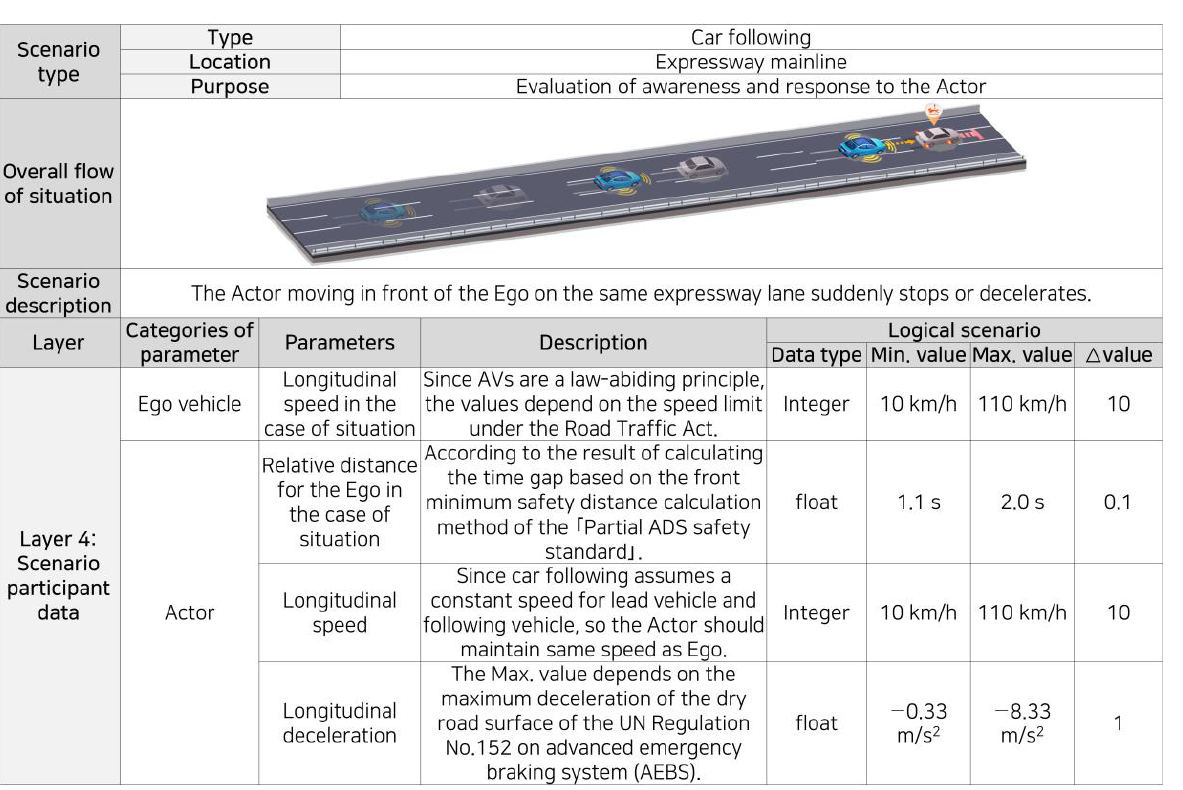
Table 4. Concrete scenario generation results.